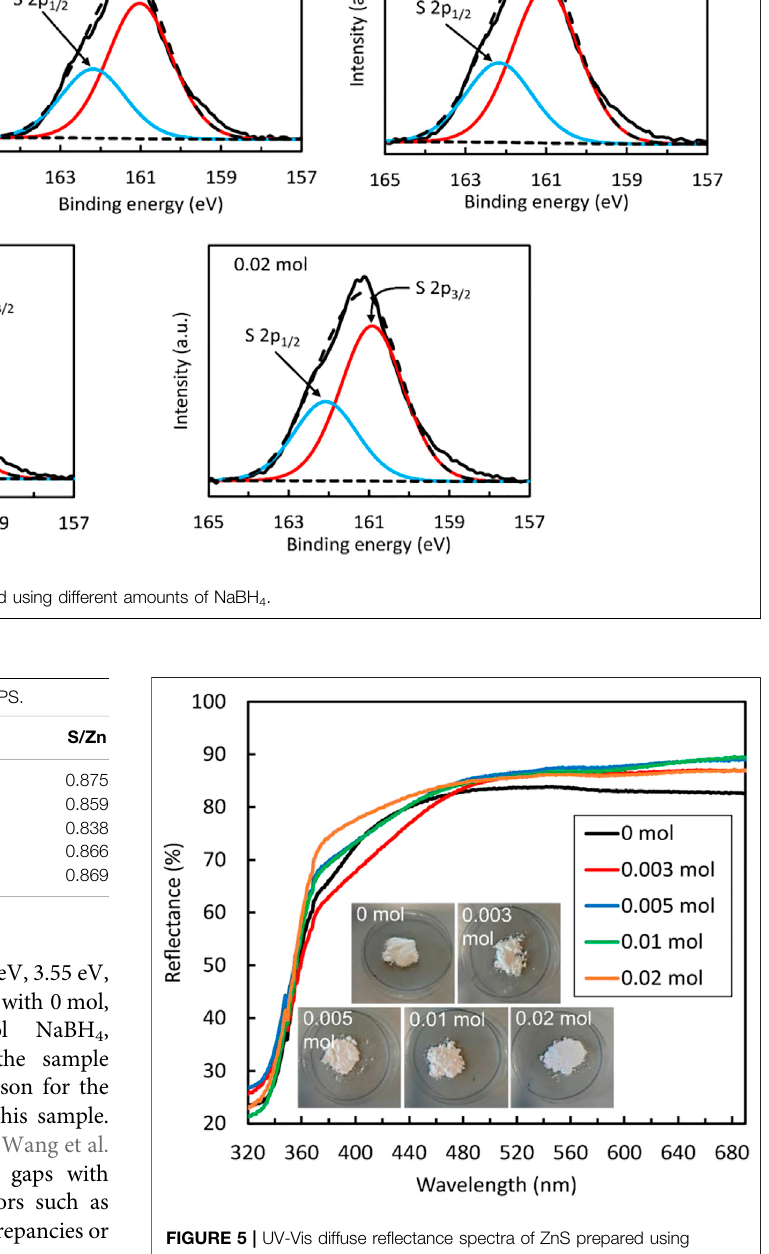
FIGURE 5 | UV-Vis diffuse re fl ectance spectra of ZnS prepared using different amounts of NaBH 4 , together with the images of the